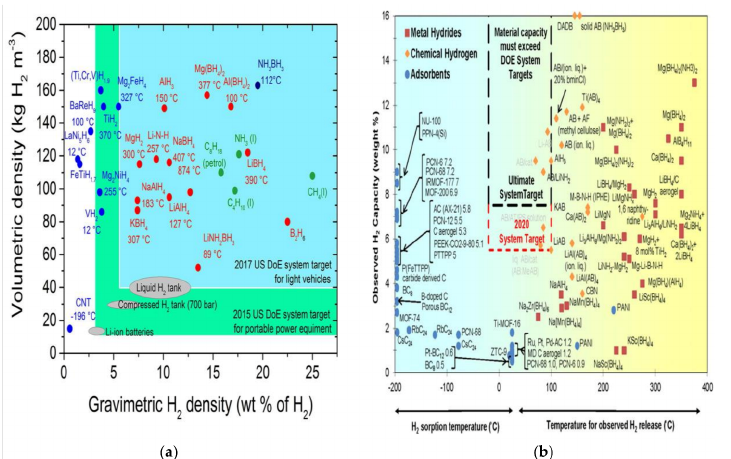
Figure 1. ( a ) Potential high-capacity hydrides. Reproduced with permission [16]. Copyright 2015, John Wiley and Sons. ( b ) Gravimetric hydrogen capacity and sorption temperature of various hydrogen storage materials. Reproduced with permission [5]. Copyright 2017, Elsevier.